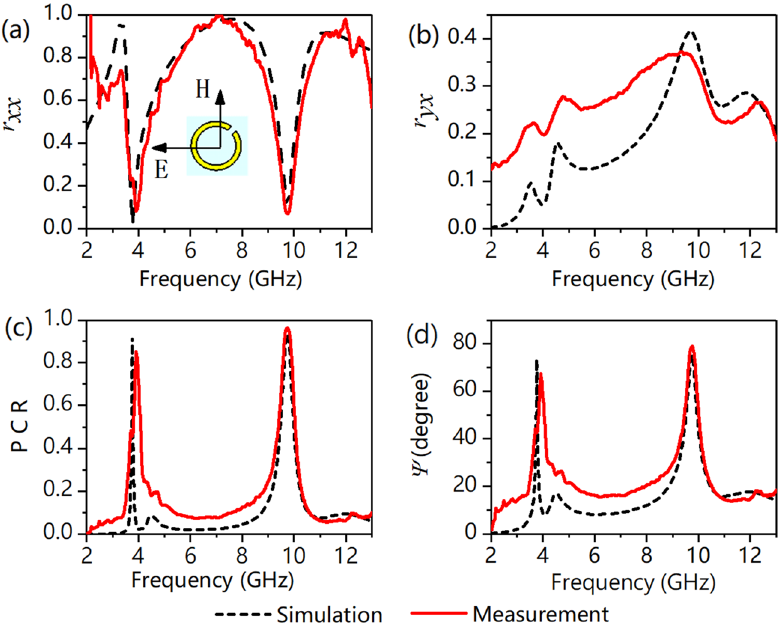
Figure 3. ( a ) Copolarization reflectance of r xx , ( b ) cross-polarization reflectance of r yx , ( c ) polarization conversion ratio (PCR), and ( d ) polarization rotation angle of Ψ . The inset of ( a ) depicts the orientation of the fields with respect to the structure, i.e., the directions of the E-field and H-field along the x- and y-axes, respectively.